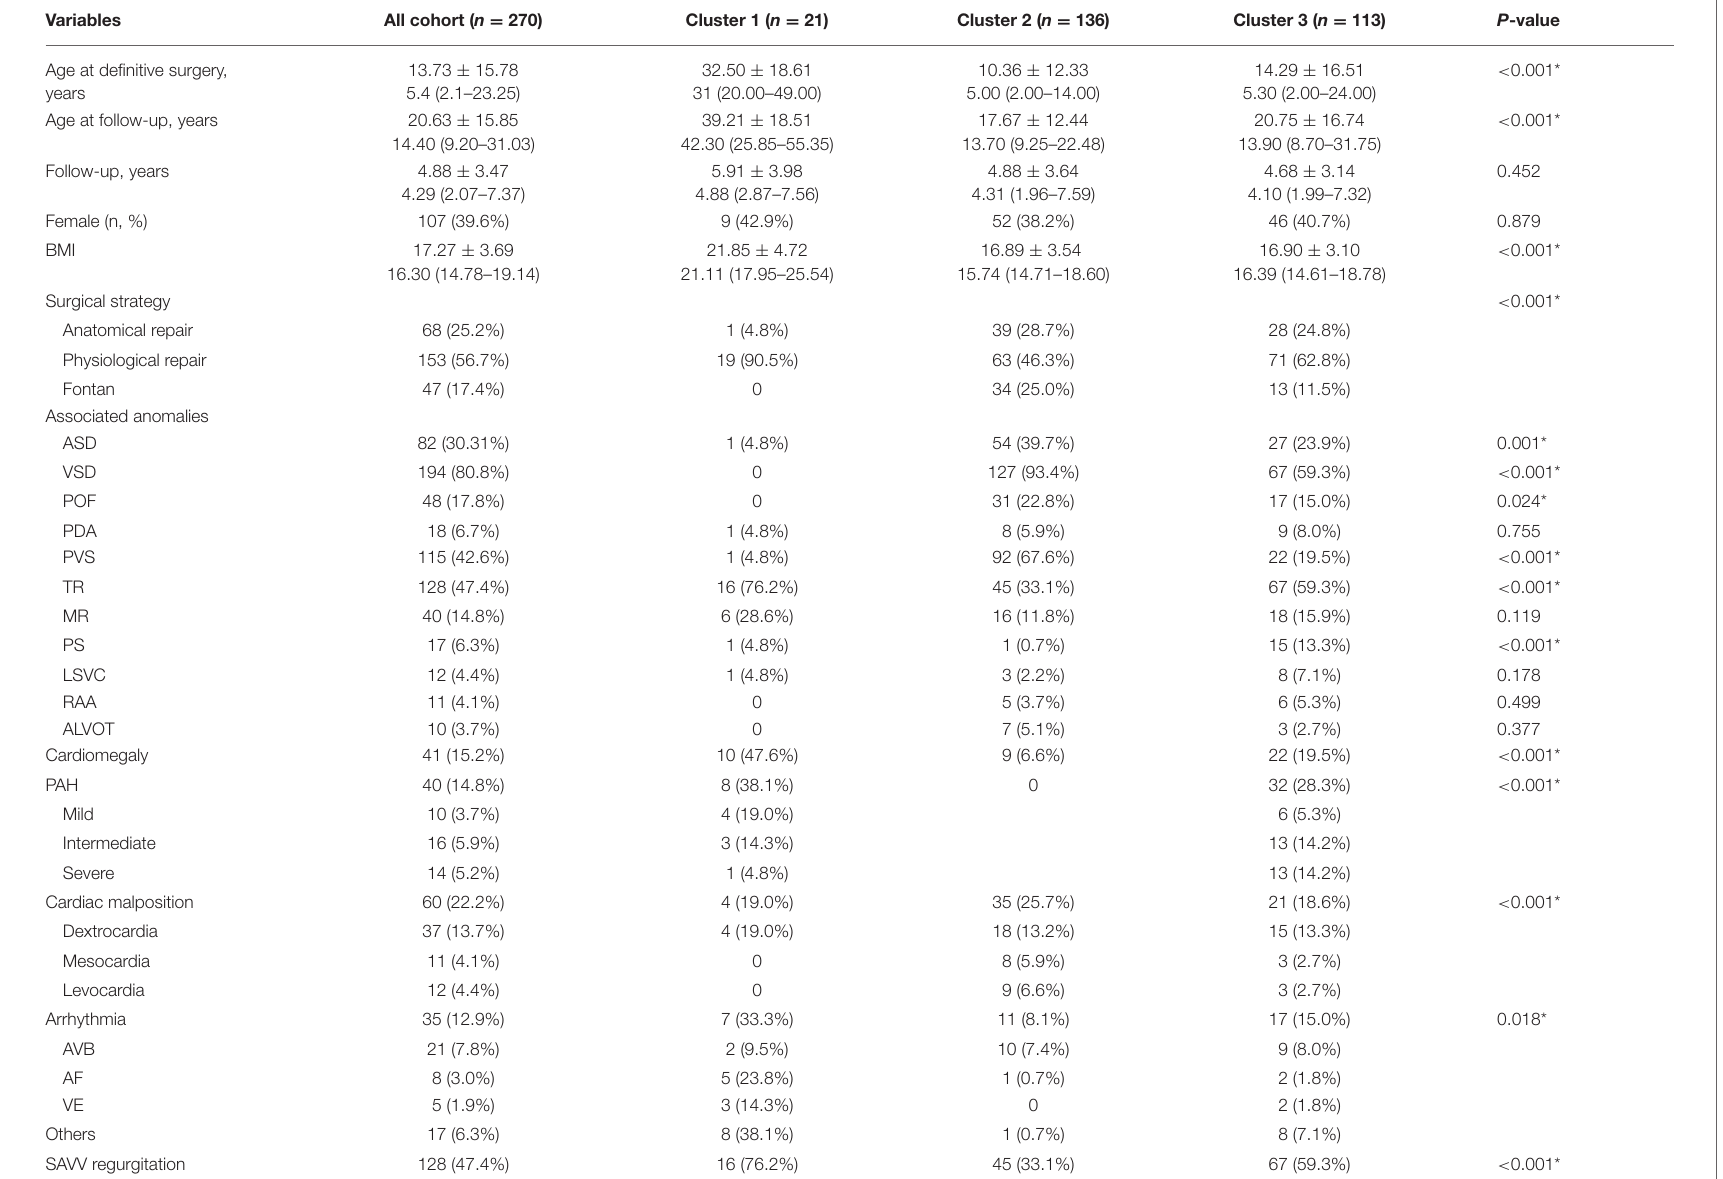
TABLE 1 | Baseline demographics of patients at definitive surgery and